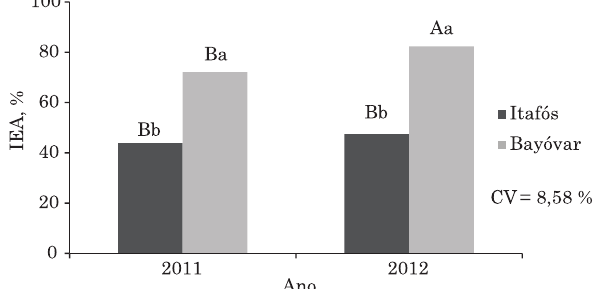
Figura 5. Índice de eficiência agronômica (IEA) dos fosfatos de rocha Itafós e Bayóvar, aplicados via adubação corretiva, em um Cambissolo cultivado com milho no Estado de Sergipe. Médias seguidas da mesma letra minúscula, para fontes, e maiúscula, para anos, não apresentam diferenças significativas pelo teste de Tukey a 5 %.